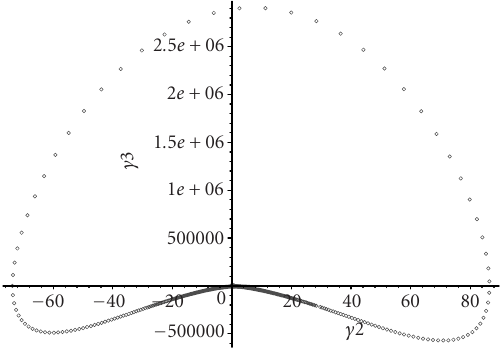
Figure 5.3. This curve continues the evolution within the attractor, starting in the neighborhood of the origin, winding up and around to the right, and terminating almost at the same point (a little above), coming in from the right.